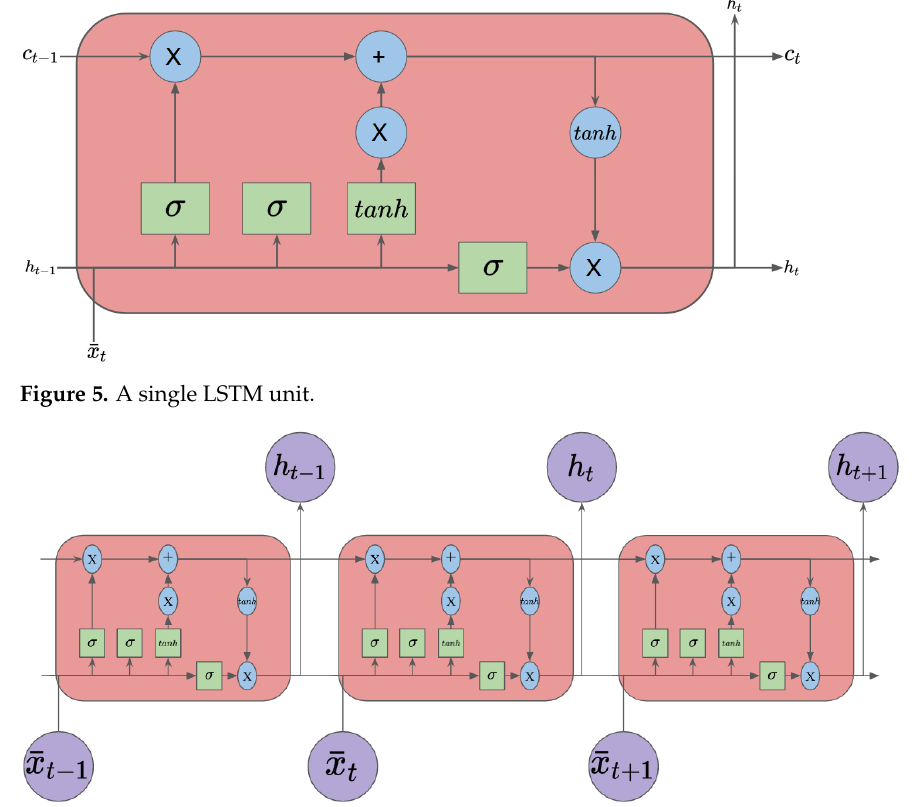
Figure 6. An unrolled Recurrent Neural Network with LSTM